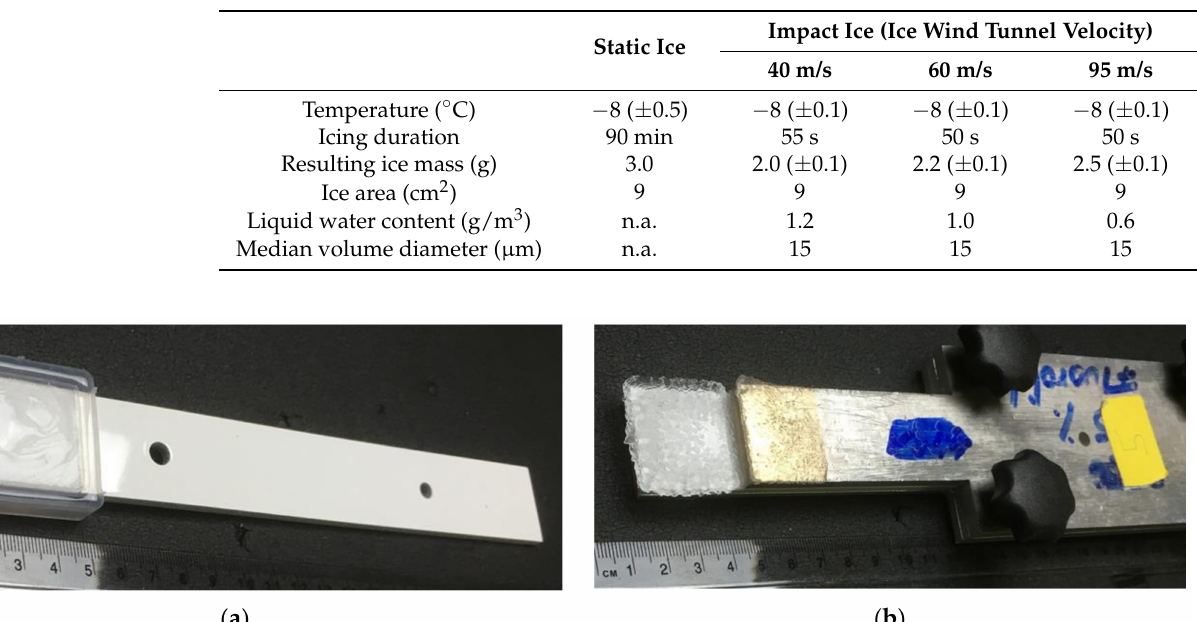
Table 3. Conditions for the ice formation processes.